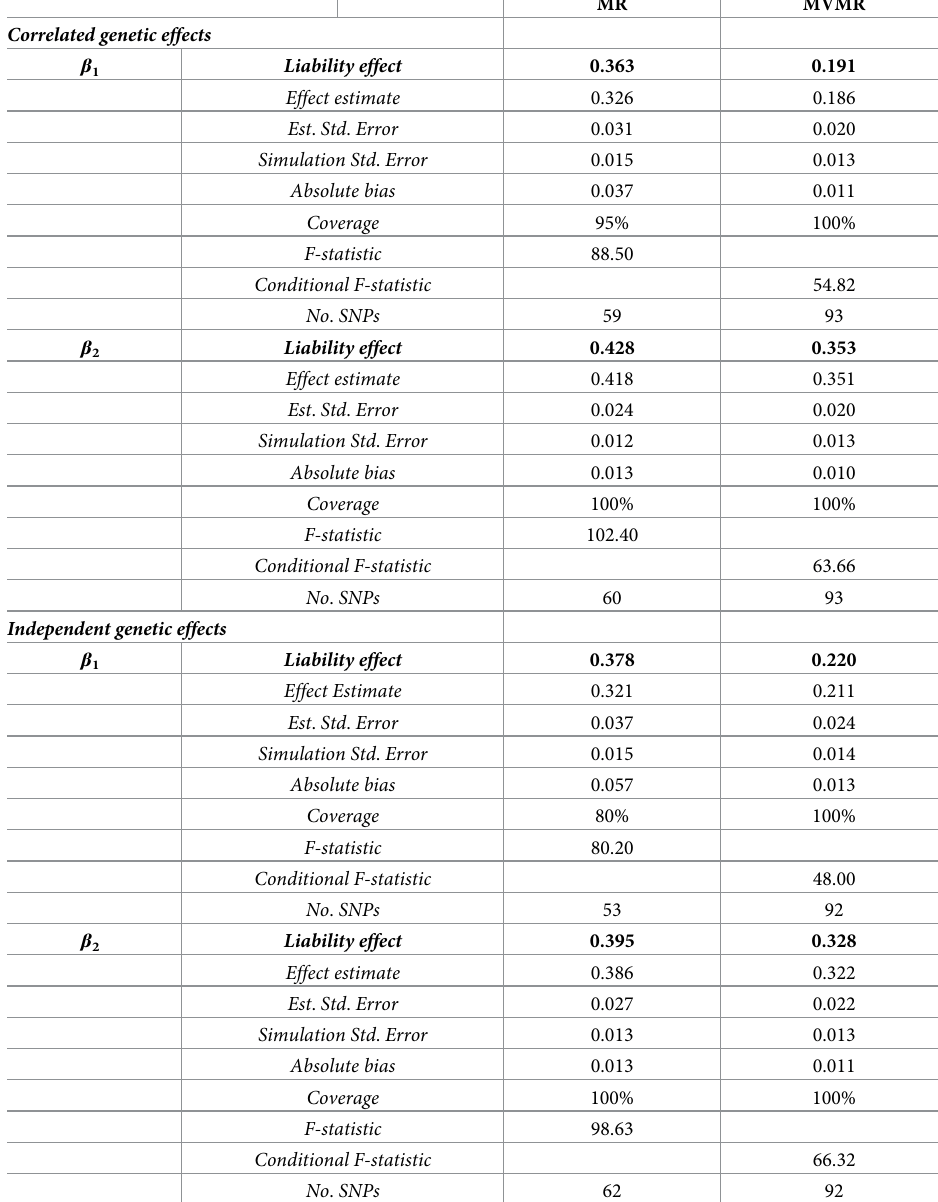
Table 3. Simulation results with a relevant liability period